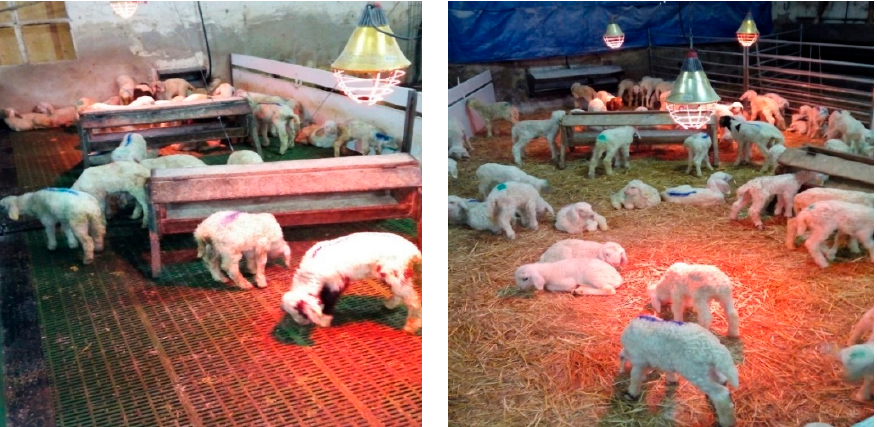
Figure 1. Corrals with plastic slat ( left ) and with a deep litter bedding system with straw ( right